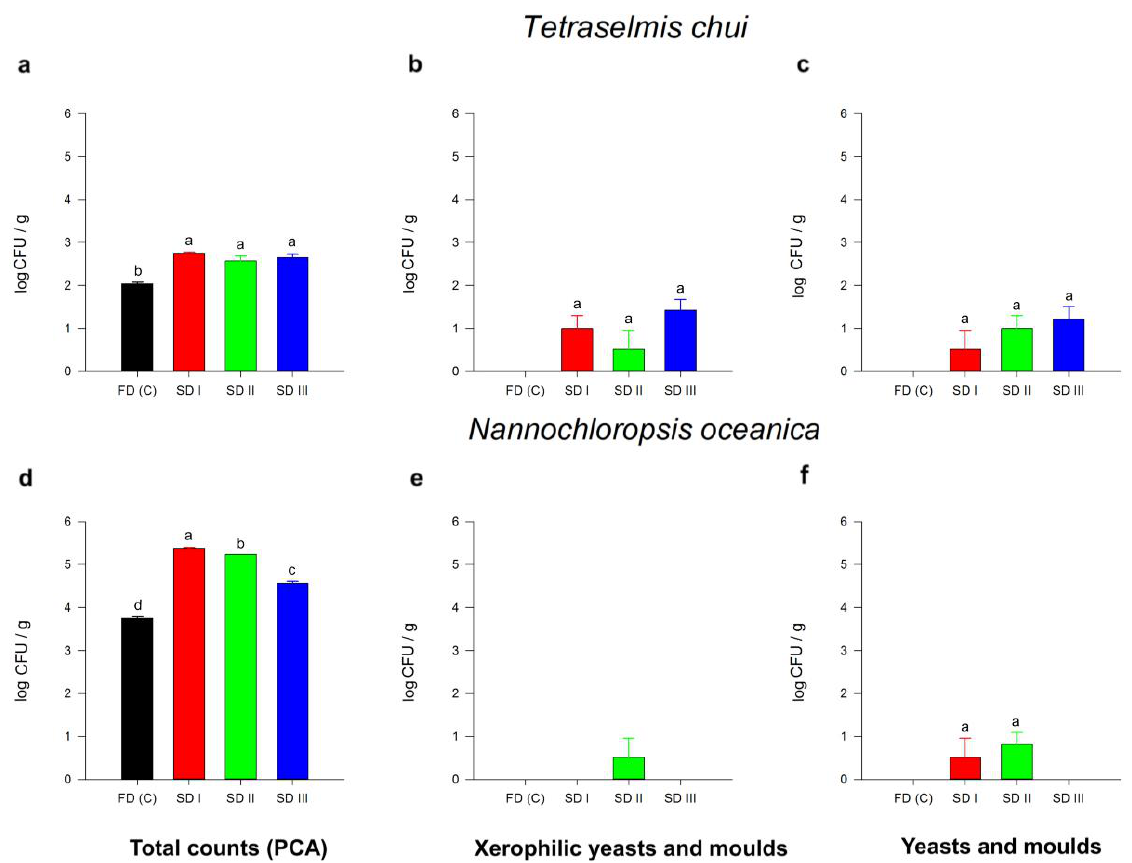
Figure 5. Total counts (PCA; a , d ), xerophilic yeasts and molds ( b , e ), and yeasts and molds ( c , f ) of solar- (SD I, II, and III) and freeze-dried (FDc) Tetraselmis chui ( a – c ) and Nannochloropsis oceanica ( d – f ) biomass. Different letters represent significant differences detected by Tukey’s post hoc range test (HSD, ANOVA). Error bars represent standard deviation (Std Dev). Data points for solar- and freeze-dried samples are shown as mean ± Std Dev ( n = 3).